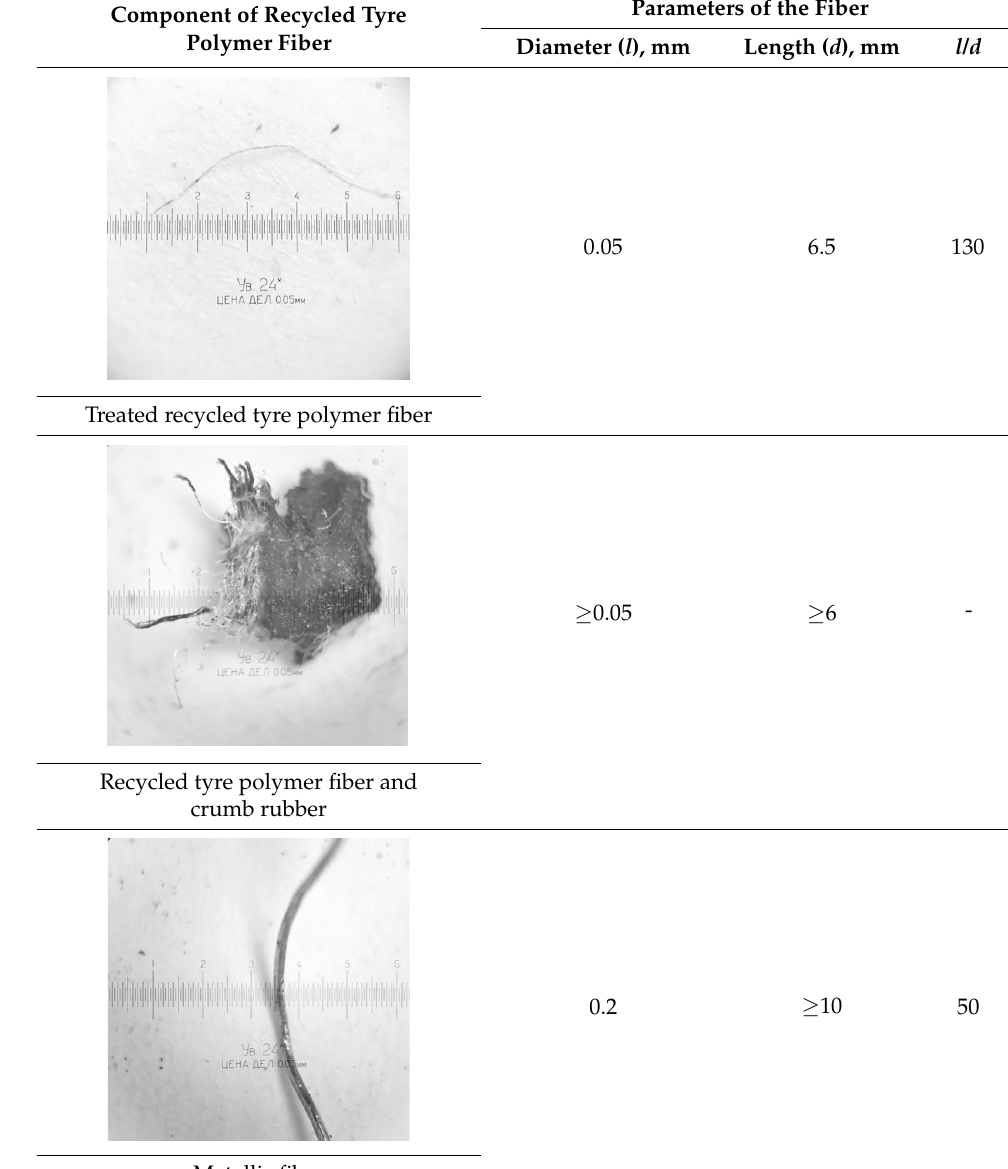
Figure 4. Tyre fiber types derived from tyre recycling. Table 3. Recycled tyre polymer fiber.